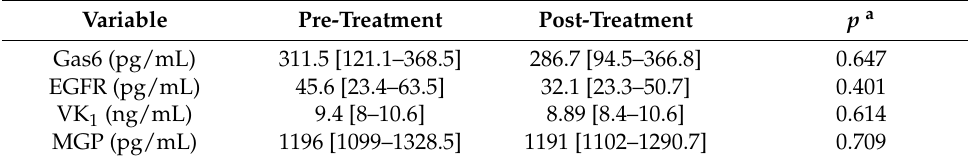
Table 2. Specific laboratory characteristics pre- and post-treatment.